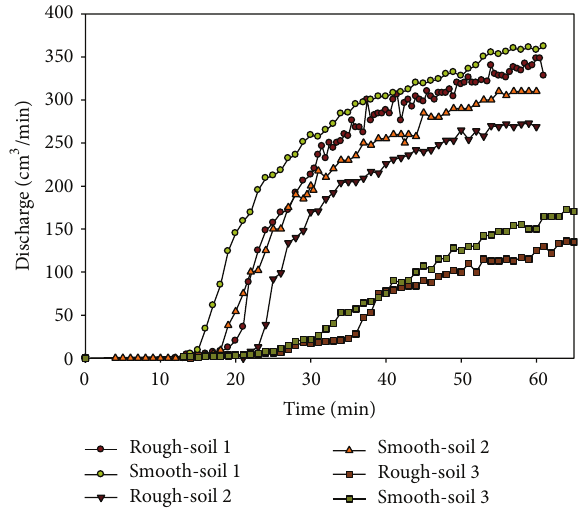
Figure 3: Observed hydrographs of the laboratory rough and smooth surfaces for three soil types (Soil 1: silty clay; Soil 2: silty clay loam; and Soil 3: loamy